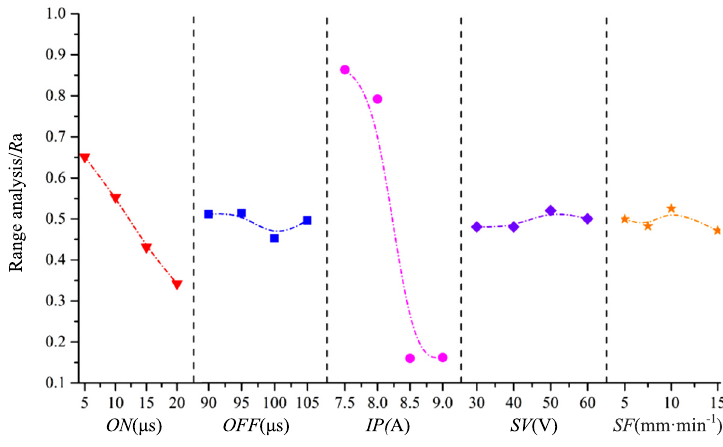
Figure 3: The e ff ect trends of the electrical parameters on surface roughness.